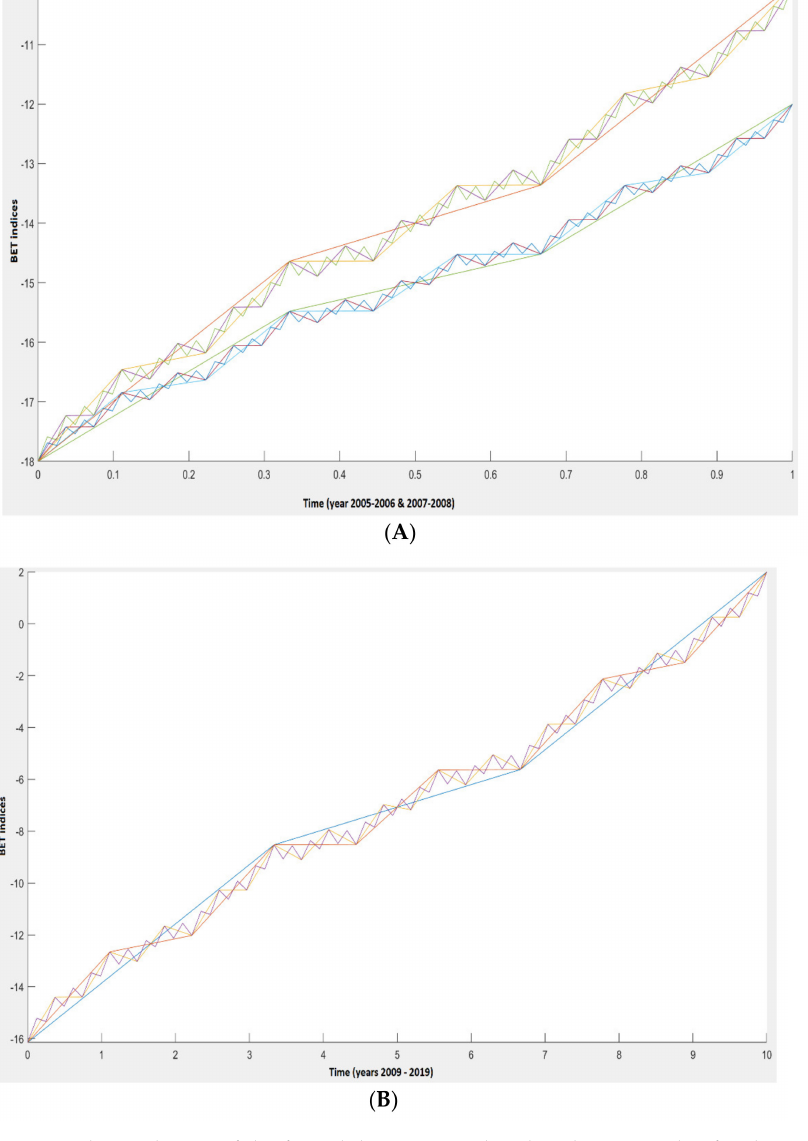
Figure 6. The evolution of the fractal dimension related to the BET index for the period 2005–2019: ( A ) 2005–2006 (green color) and 2007–2008 (blue color); ( B ) period